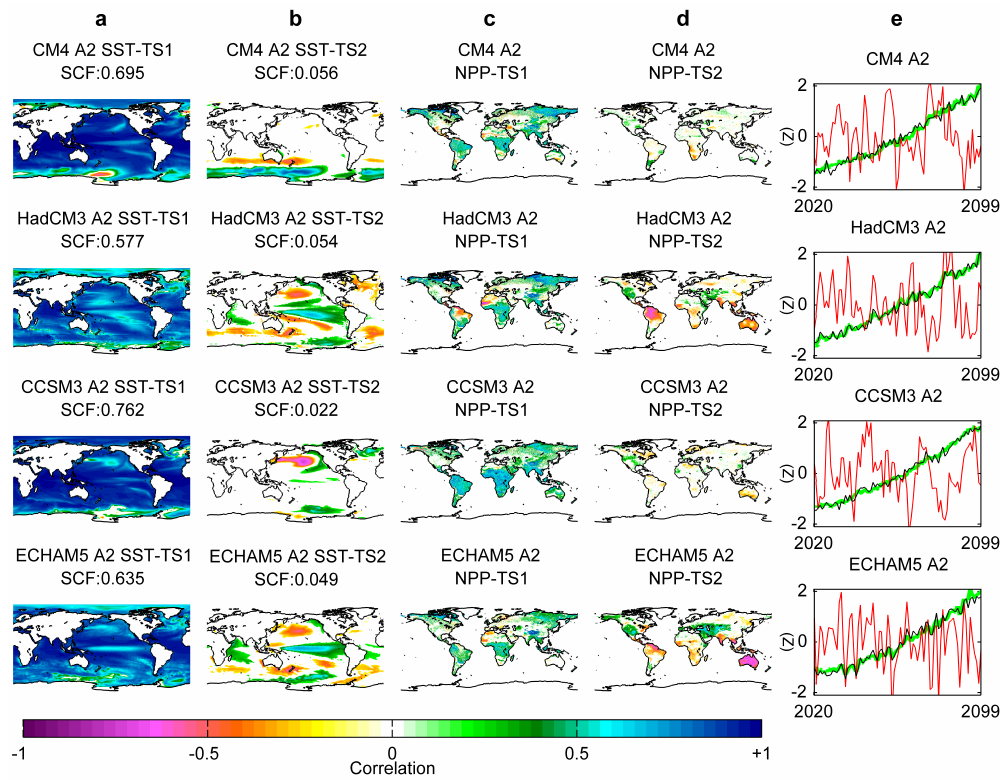
Fig. 2. Spatial patterns of correlation (Pearson r ) between the first two EOF modes of GCM-simulated SST under the A2 scenario and the original simulated SST and simulated NPP. (a) Correlations between original SST and the time series of the first EOF mode (TS1; green line in (e) ). (b) Correlations between original SST and the time series of the second EOF mode (TS2; red line in (e) ). (c) Correlations between simulated NPP and the time series of the first EOF mode. (d) Correlations between simulated NPP and the time series of the second EOF mode. (e) Standardized time series (Z-scores) with mean zero and standard deviation one, of the first EOF mode, TS1, (green), second EOF mode, TS2, (red) and global land temperature (black). The correlations presented in colours are all statistically significant at 5%